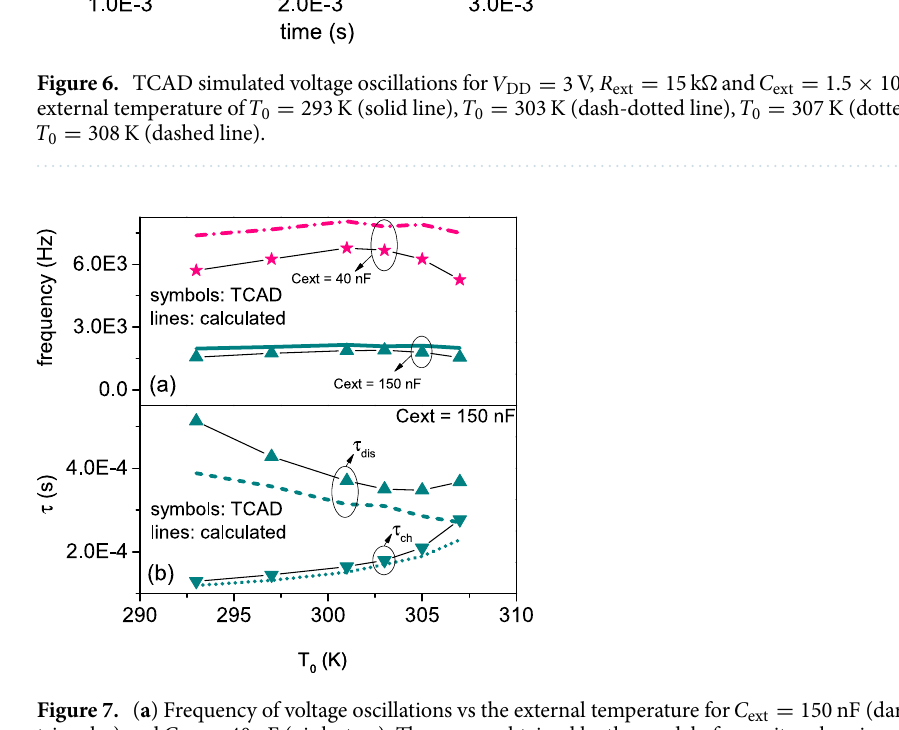
Figure 7. ( a ) Frequency of voltage oscillations vs the external temperature for C ext = 150 nF (dark cyan triangles) and C ext = 40 nF (pink stars). The curves obtained by the model of capacitor charging and discharging 37 (pink dashed and dark cyan solid lines) are also plotted. ( b ) TCAD simulated periods of charging τ ch (downward triangles) and discharging τ dis (upward triangles) for C ext = 150 nF. The dotted and dashed lines are the curves for τ ch , τ dis by applying the circuit equations 37